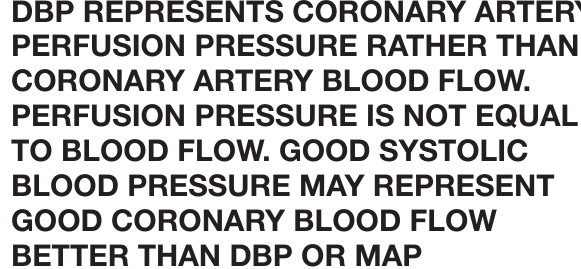
FIGURE 2 | (A) Different pulsatile flow on tissue perfusion. Significant pulsatile blood flow will produce more shear stress to dilate micro-vessels. According to Poiseuille’s Law: R (Resistance) = 8 η L/ π R ∧ 4 , these dilated micro-vessels will have more blood flow. However, small pulsatile blood flow will be difficult to dilate micro-vessels and, as a result, these vessels will have less blood perfusion. (B) Effect of aorta stiffness on target organs’ injury and hemodynamic management policy perioperatively. Aortic stiffness will produce higher SBP and higher PWV, which can cause myocardial hypertrophy and other low resistance organs’ (brain, kidney, etc.) micro-circulation sclerosis. So, the heart may need higher DBP and other organs might need higher MAP or SBP to perfuse them perioperatively. (C) Good SBP reflects good coronary perfusion. The typical theory informs us that the coronary perfusion depends on DBP because the ventricular wall tension, especially the left ventricular wall tension, is lower during the diastolic phase. However, good DBP does not represent good coronary perfusion because heart rate and ventricular end diastolic pressure will influence coronary perfusion by interfering with diastolic duration and coronary microcirculation resistance. Good SBP may reflect good heart contraction, which is regarded as the result of enough coronary blood flow. SBP, systolic blood pressure. DBP, diastolic blood pressure. PWV, pulse wave velocity. MAP, mean artery pressure.